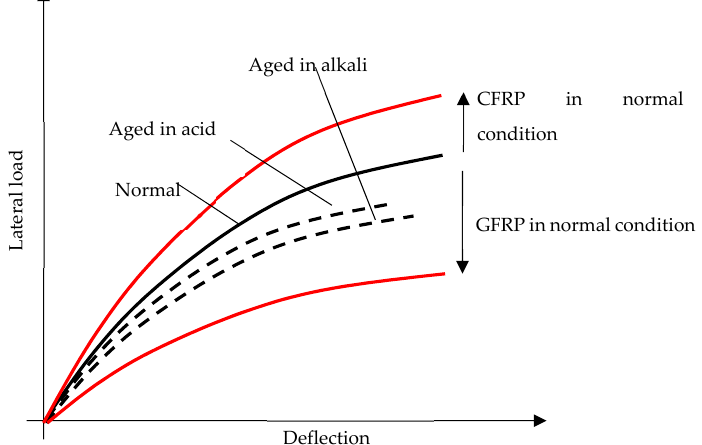
Figure 15. The aging environment and FRP type affect the behaviour of FRP piles under a lateral load.